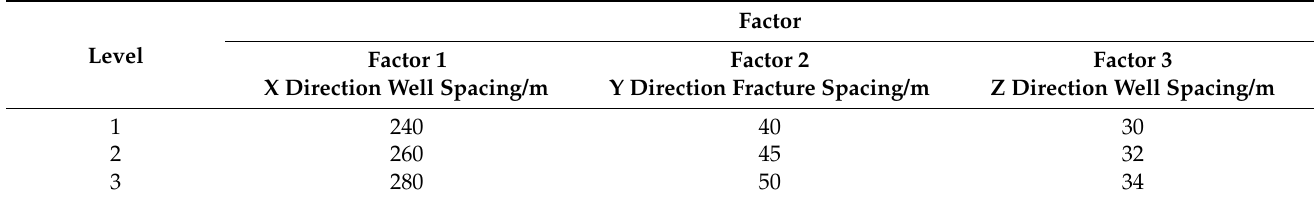
Table 4. Orthogonal design table of horizontal wells.